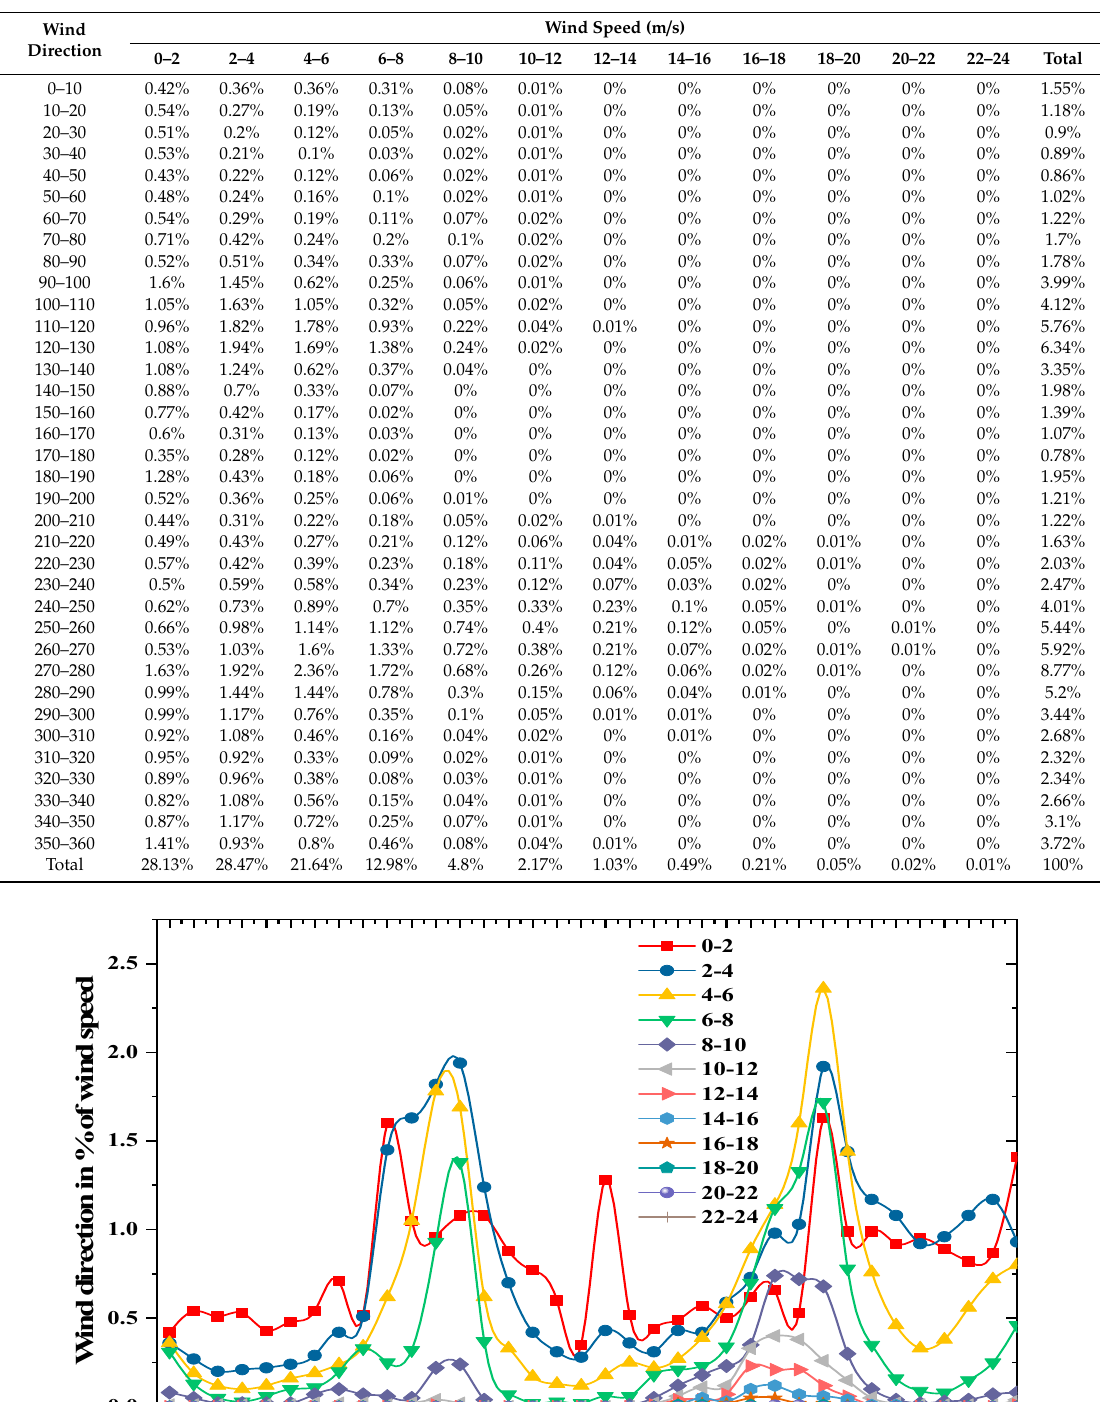
Table 5. Distribution of the wind direction based on wind speed frequency.